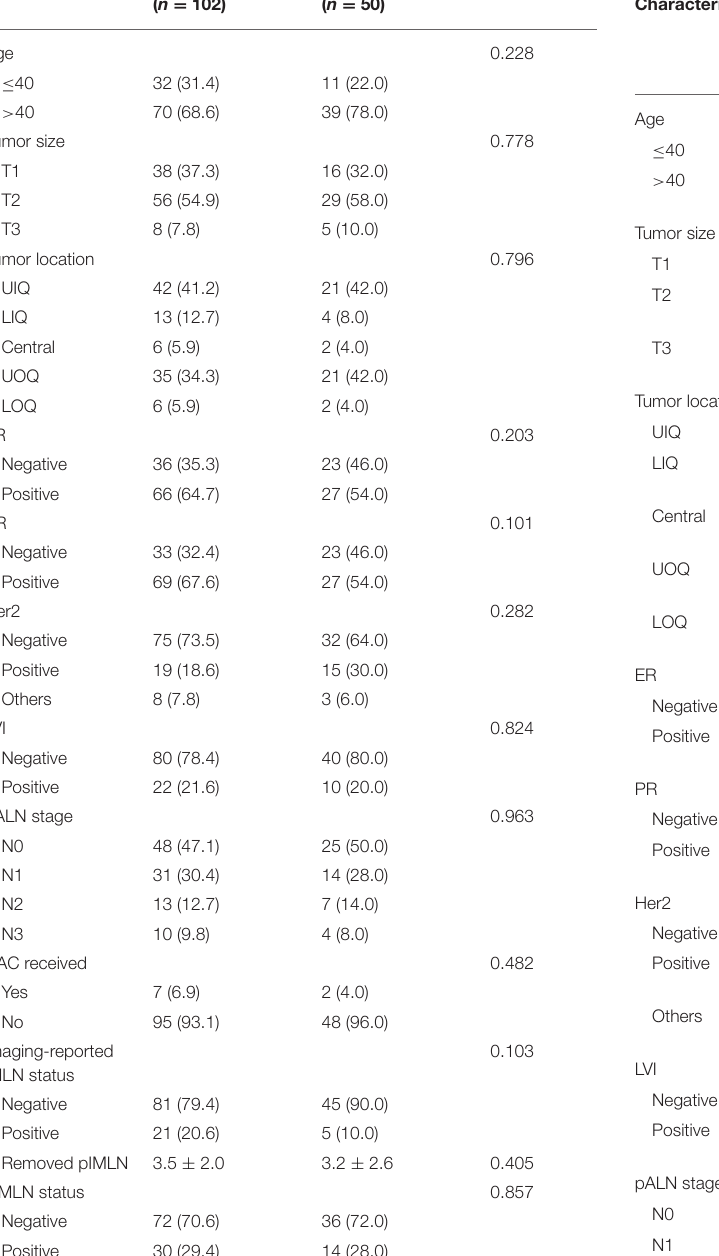
TABLE 1 | Clinicopathological characters in training and validation cohorts. TABLE 2 | Univariate and multivariate analysis for factors associated with internal mammary lymph node (IMLN) metastasis.